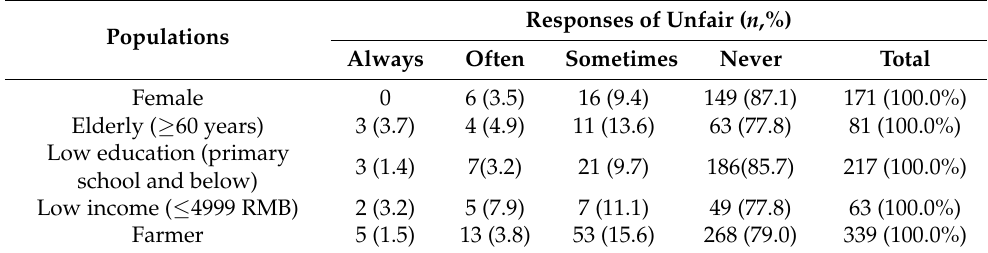
Table 4. Distribution of patient-perceived HSR among disadvantaged groups.